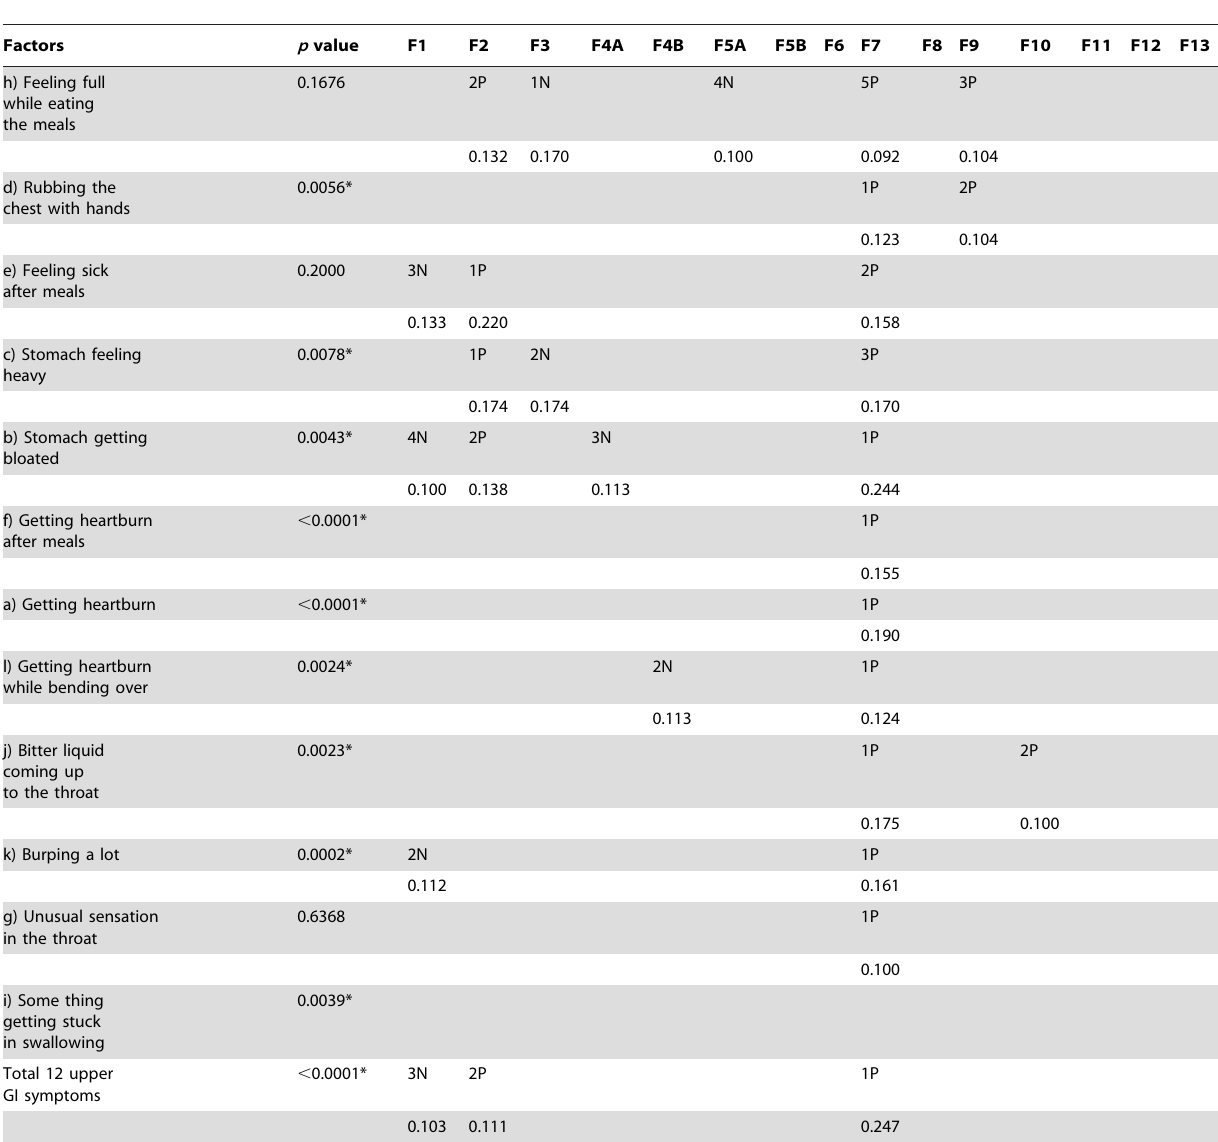
Table 4. Orders, directions, and standardized coefficients of associations between the 12 upper GI symptoms and 13 background factors among the 528 H 2 RA